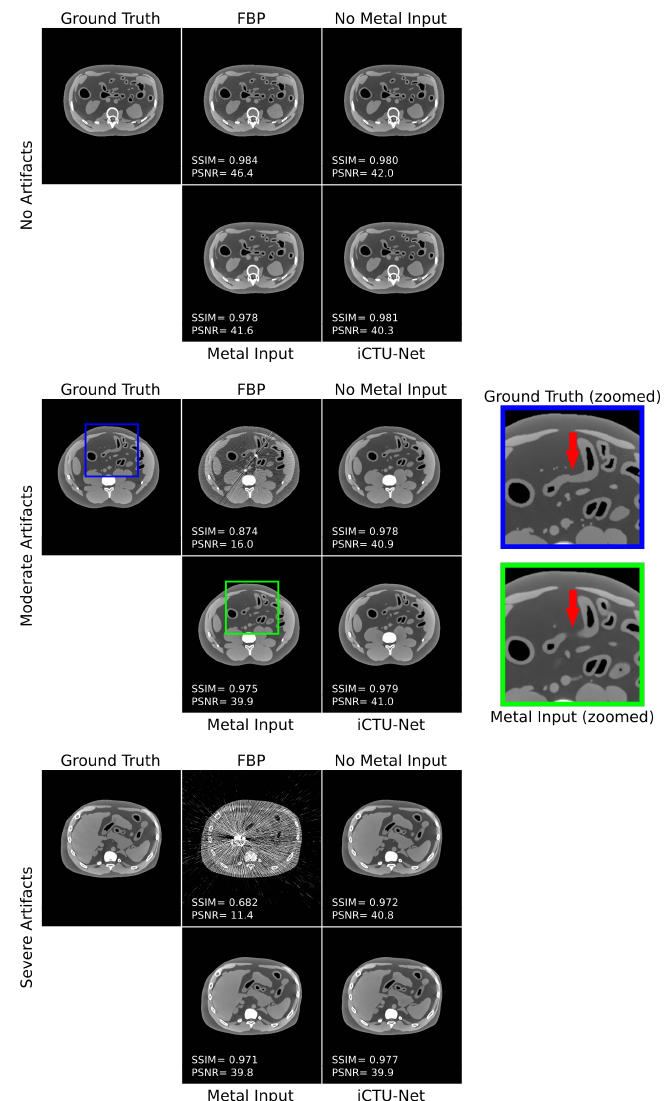
Figure 5. Results of the input study, where the ground truth and FBP are compared to iCTU-Nets trained with different input sinograms. All networks are trained with the U-Net post-processing layers and the SSIM loss, which yield the best results in the ablation study. No Metal Input, Metal Input, and iCTU-Net are, respectively, trained with metal-free, metal, and NMAR pre-corrected sinograms. A slice without metal artifacts, with moderate metal artifacts, and with severe metal artifacts is shown. The scans are windowed to [ − 300 HU, 300 HU] to increase the visibility of the artifacts. The arrows in the zoomed images indicate an anatomy that the Metal Input network cannot resolve